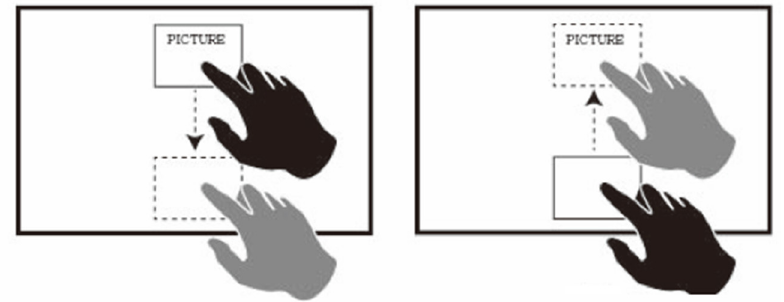
Figure 1. The figure represents the two groups’ touch-screen tablet AAT. Dashed areas show the swipe endpoints. Arrows depict the movement